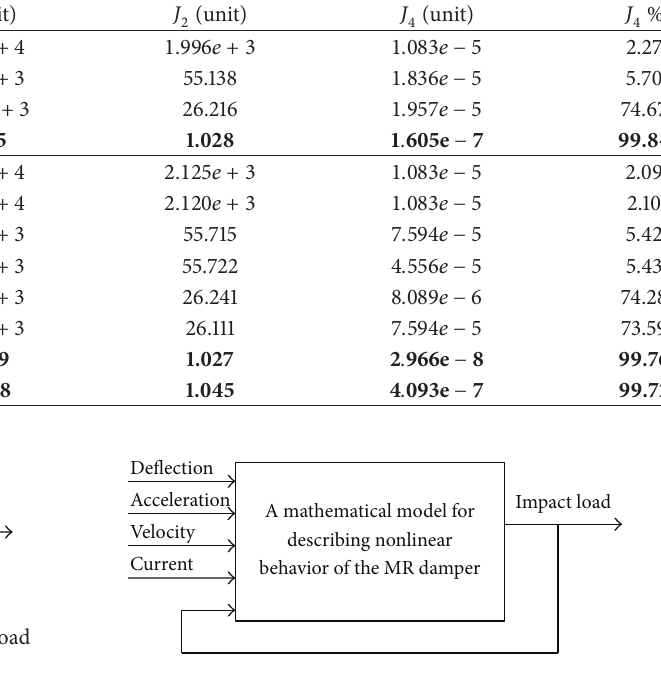
Figure 16: Configuration of the OF neurofuzzy model: impact load